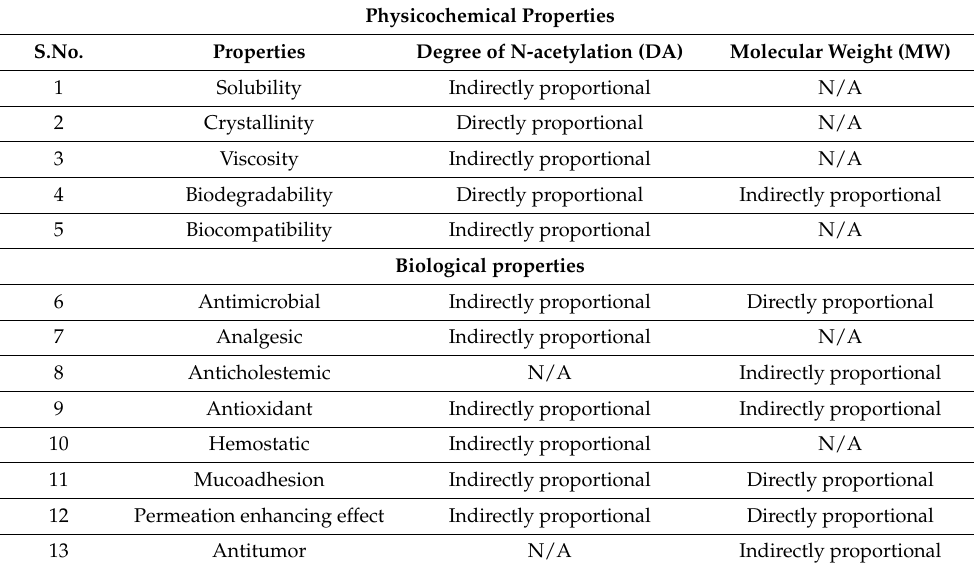
Table 3. Influence of Mw and DA on physicochemical and biological properties